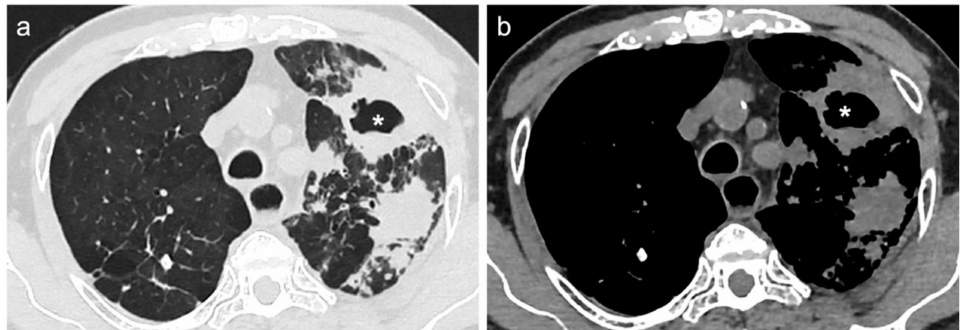
Figure 2. ( a ) Lung window and ( b ) mediastinal window of axial thin-section unenhanced chest CT images of a 76-year-old man, who is a former smoker. Images show multiple gross consolidation opacities without air-bronchogram, with irregular margins in the left upper lobe, as well as a cavitation (asterisks) within the contest and interstitial septal thickening. Diagnosis of lung cancer was confirmed by pulmonary